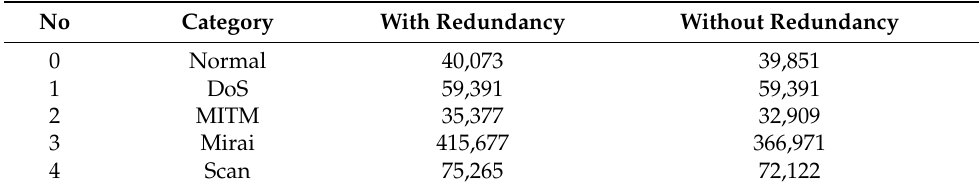
Table 3. IoT network intrusion dataset instances.